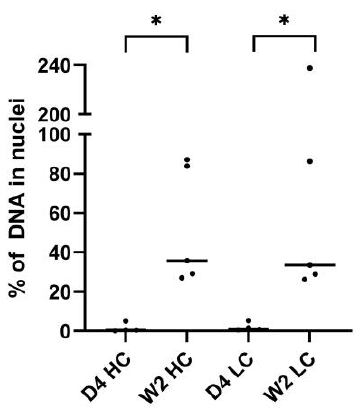
Figure 7. qPCR percentage nuclear pDNA. Balb/c mice received intramuscular pDNA electrotransfer Figure 7. qPCR percentage nuclear pDNA . Balb/c mice received intramuscular pDNA electrotrans- of 60 µ g pDNA (equimolar mixture pCAG-4D5-HC and pCAG-4D5-LC) in the tibialis anterior muscle. fer of 60 µg pDNA (equimolar mixture pCAG-4D5-HC and pCAG-4D5-LC) in the tibialis anterior Figure 7. qPCR percentage nuclear pDNA . Balb/c mice received intramuscular pDNA electrotrans- Figure 7. qPCR percentage nuclear pDNA . Balb/c mice received intramuscular pDNA electrotrans- Figure 7. qPCR percentage nuclear pDNA . Balb/c mice received intramuscular pDNA electrotrans- Figure 7. qPCR percentage nuclear pDNA . Balb/c mice received intramuscular pDNA electrotrans- Figure 7. qPCR percentage nuclear pDNA . Balb/c mice received intramuscular pDNA electrotrans- Nuclear pDNA quantification by qPCR, data points indicate the percentage of total pDNA in nuclei. muscle. Nuclear pDNA quantification by qPCR, data points indicate the percentage of total pDNA fer of 60 µg pDNA (equimolar mixture pCAG-4D5-HC and pCAG-4D5-LC) in the tibialis anterior fer of 60 µg pDNA (equimolar mixture pCAG-4D5-HC and pCAG-4D5-LC) in the tibialis anterior fer of 60 µg pDNA (equimolar mixture pCAG-4D5-HC and pCAG-4D5-LC) in the tibialis anterior fer of 60 µg pDNA (equimolar mixture pCAG-4D5-HC and pCAG-4D5-LC) in the tibialis anterior fer of 60 µg pDNA (equimolar mixture pCAG-4D5-HC and pCAG-4D5-LC) in the tibialis anterior The horizontal lines represent the median per subgroup (day 4: n = 4, week 2: n = 5). Asterisks in nuclei. The horizontal lines represent the median per subgroup (day 4: n = 4, week 2: n = 5). As- muscle. Nuclear pDNA quantification by qPCR, data points indicate the percentage of total pDNA muscle. Nuclear pDNA quantification by qPCR, data points indicate the percentage of total pDNA muscle. Nuclear pDNA quantification by qPCR, data points indicate the percentage of total pDNA muscle. Nuclear pDNA quantification by qPCR, data points indicate the percentage of total pDNA muscle. Nuclear pDNA quantification by qPCR, data points indicate the percentage of total pDNA terisks represent the level of statistical significance: * p ≤ 0.05. represent the level of statistical significance: * p ≤ in nuclei. The horizontal lines represent the median per subgroup (day 4: n = 4, week 2: n = 5). As- in nuclei. The horizontal lines represent the median per subgroup (day 4: n = 4, week 2: n = 5). As- in nuclei. The horizontal lines represent the median per subgroup (day 4: n = 4, week 2: n = 5). As- in nuclei. The horizontal lines represent the median per subgroup (day 4: n = 4, week 2: n = 5). As- in nuclei. The horizontal lines represent the median per subgroup (day 4: n = 4, week 2: n = 5). As- terisks represent the level of statistical significance: * p ≤ 0.05. terisks represent the level of statistical significance: * p ≤ 0.05. terisks represent the level of statistical significance: * p ≤ 0.05. terisks represent the level of statistical significance: * p ≤ 0.05. terisks represent the level of statistical significance: * p ≤ 0.05.